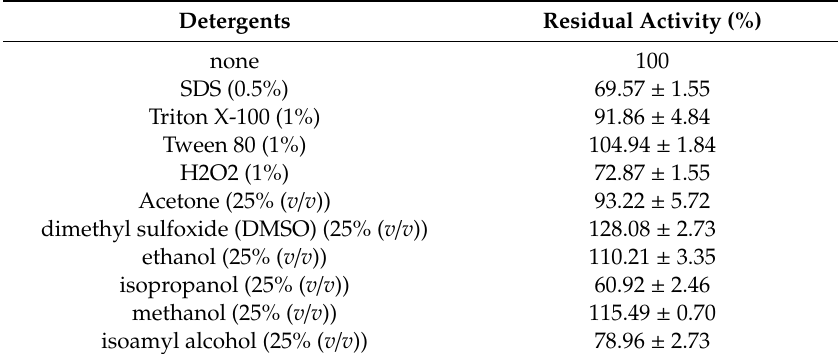
Activity and stability of EH2 in the presence of surfactants, oxidizing agents, and organic